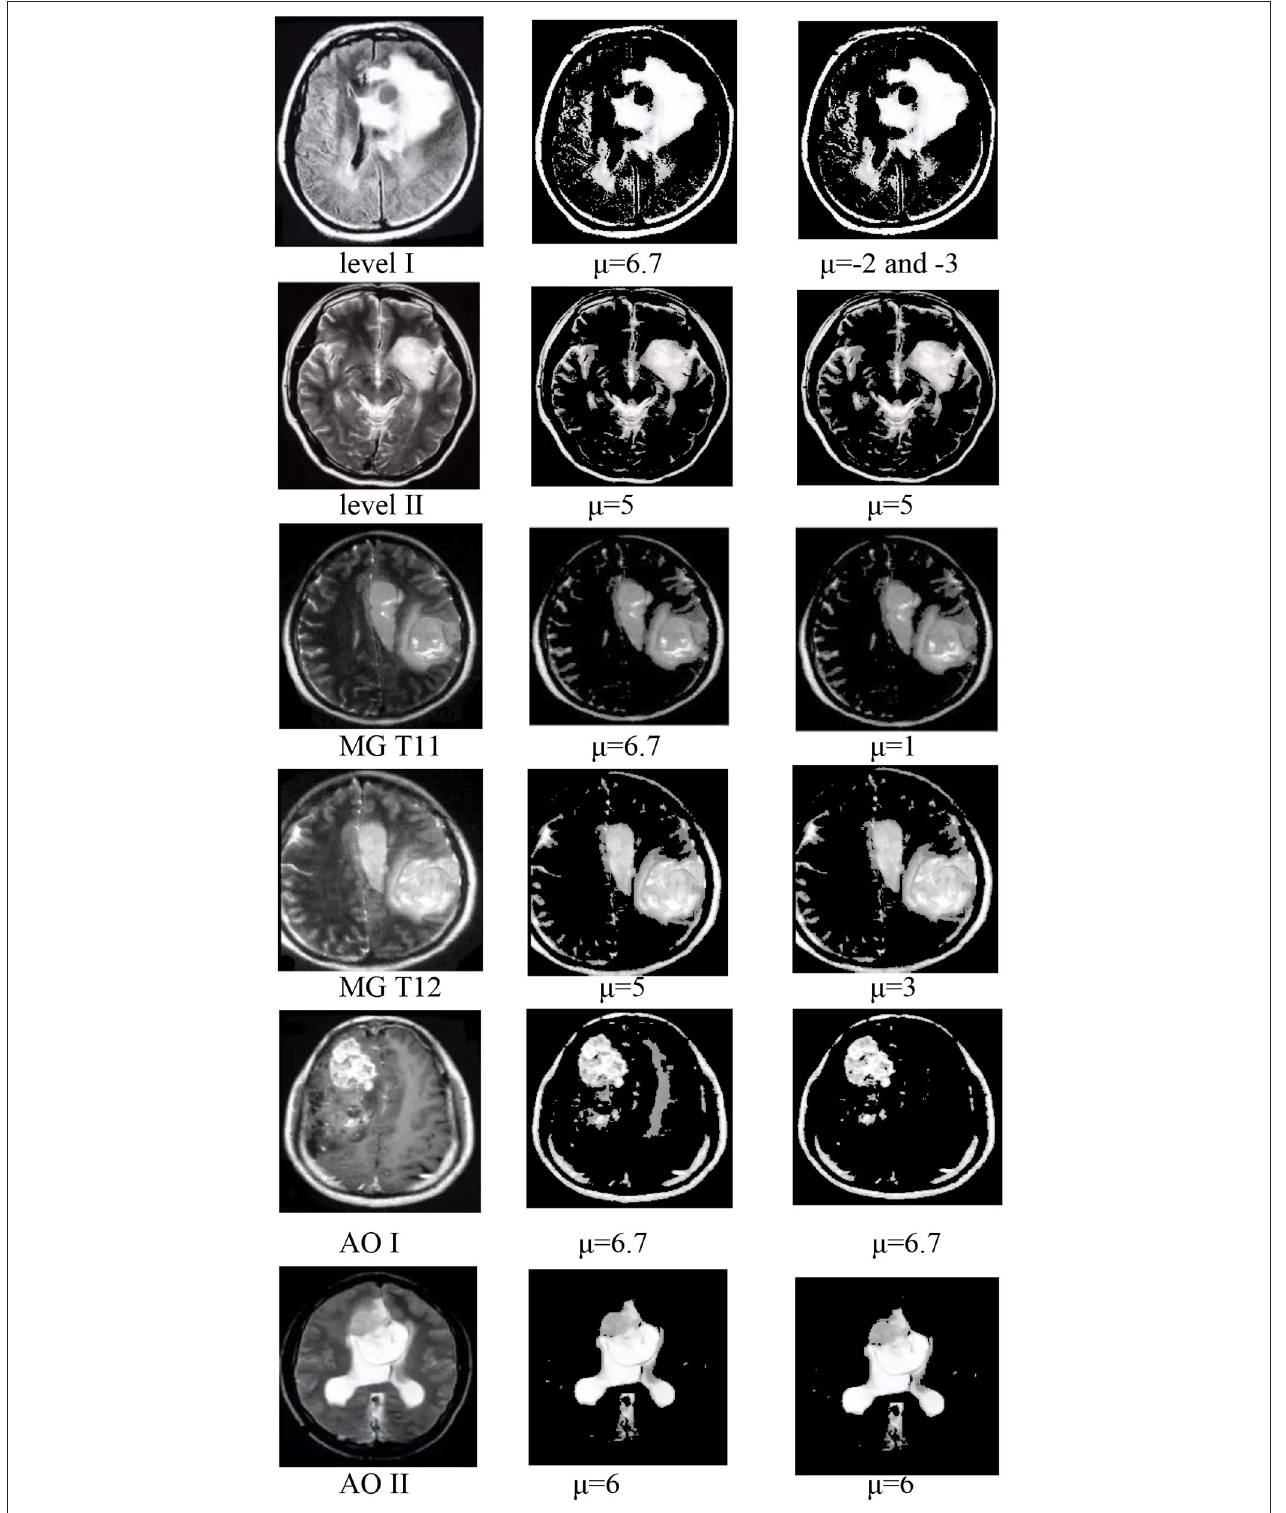
FIGURE 12 | Image of group 2 and its best value